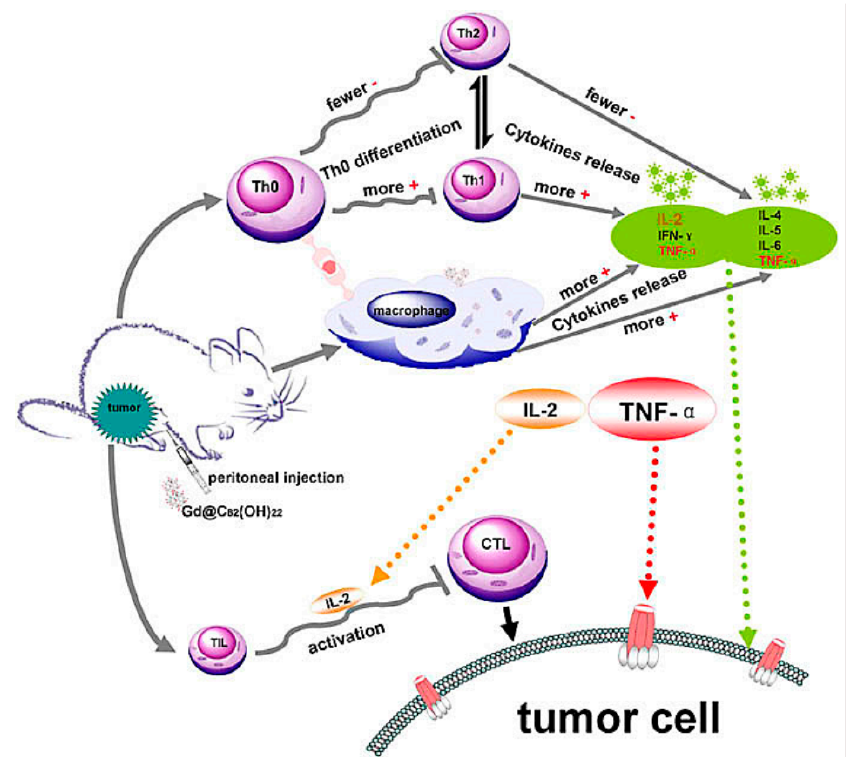
Figure 2. Possible immuno-mechanism related with the anti-tumor activity of Gd@C 82 (OH) 22 particles